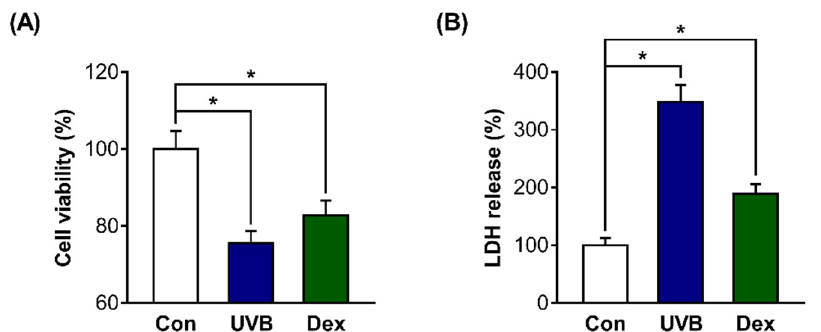
Figure 1. Inhibitory effects of ultraviolet B (UVB) radiation or dexamethasone (Dex) on Hs68 cell survival. ( A ) The cells were treated with 20 mJ/cm 2 UVB or 1 µ M Dex, or without them (control (Con)). After treatment for 24 h, the cell viability was determined using a water-soluble tetrazolium salt-1 (WST-1) assay. ( B ) The death of the cells treated with UVB or Dex was analyzed by lactate dehydrogenase (LDH) assay. The results are expressed as mean ± standard error of mean (SEM) of three independent experiments. * p < 0.05.